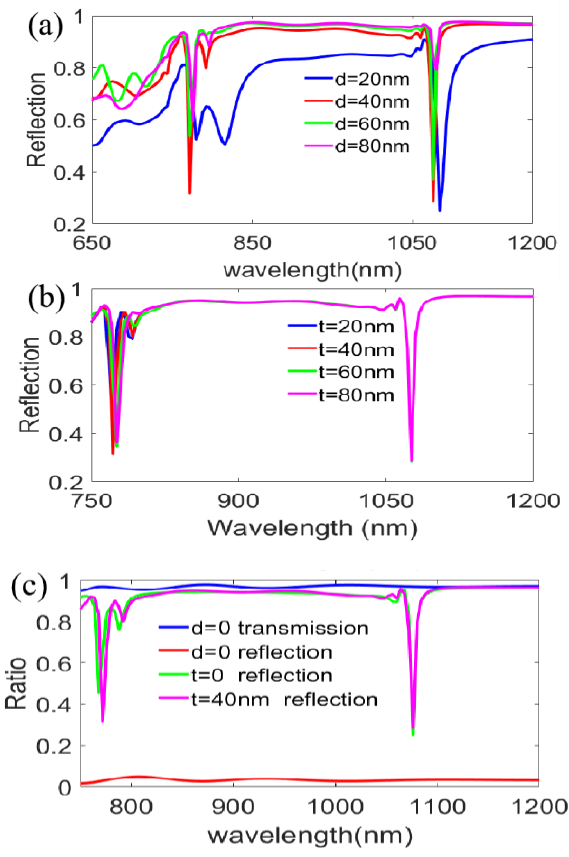
Figure 13. Influence of the metal film thickness with non-synchronous change of the top and bottom on the characteristics for TM polarized incidence at θ = 10° from the structural bottom. ( a ) Change thickness of the bottom film; ( b ) Change thickness of the top film; ( c ) Spectral comparisons with different metal film thicknesses.